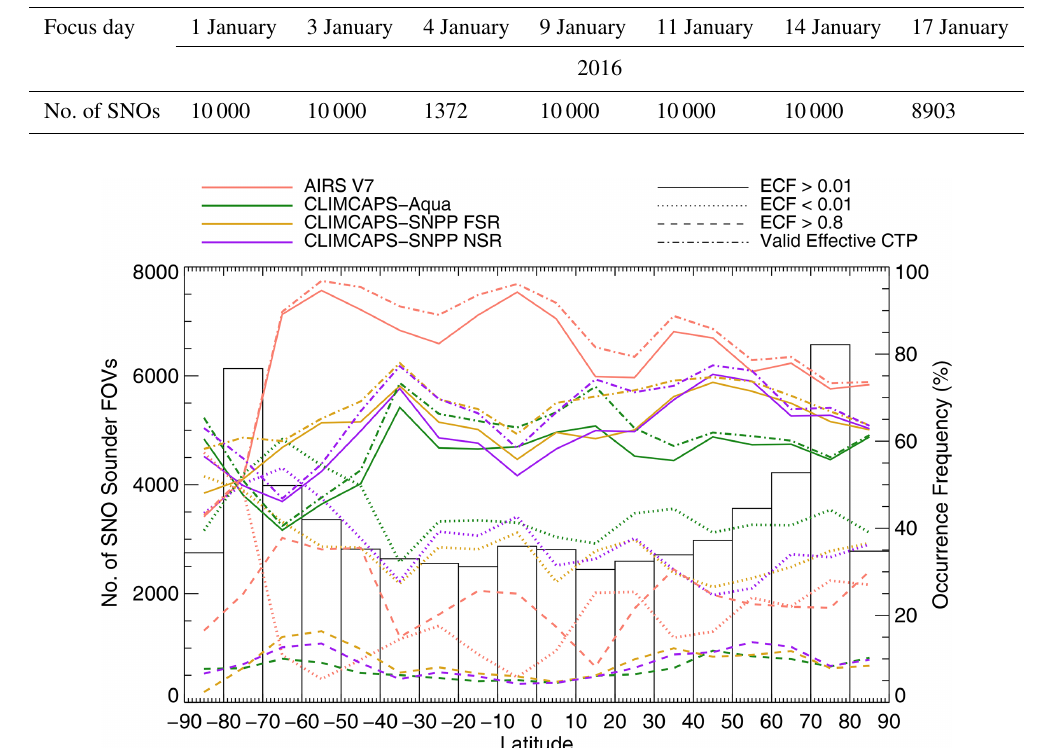
Table 2. Number of SNOs between Aqua AIRS and SNPP CrIS on the 7 focus days used in this study. Focus day